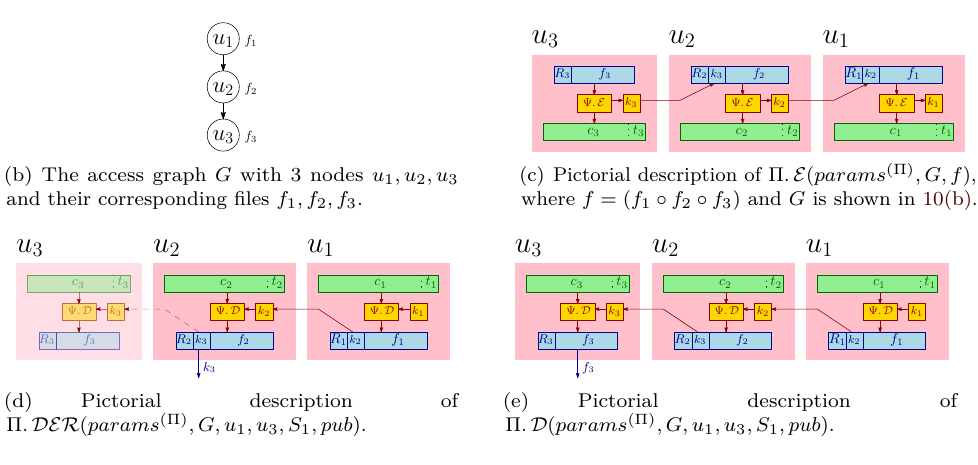
Figure 10: Building B Chain